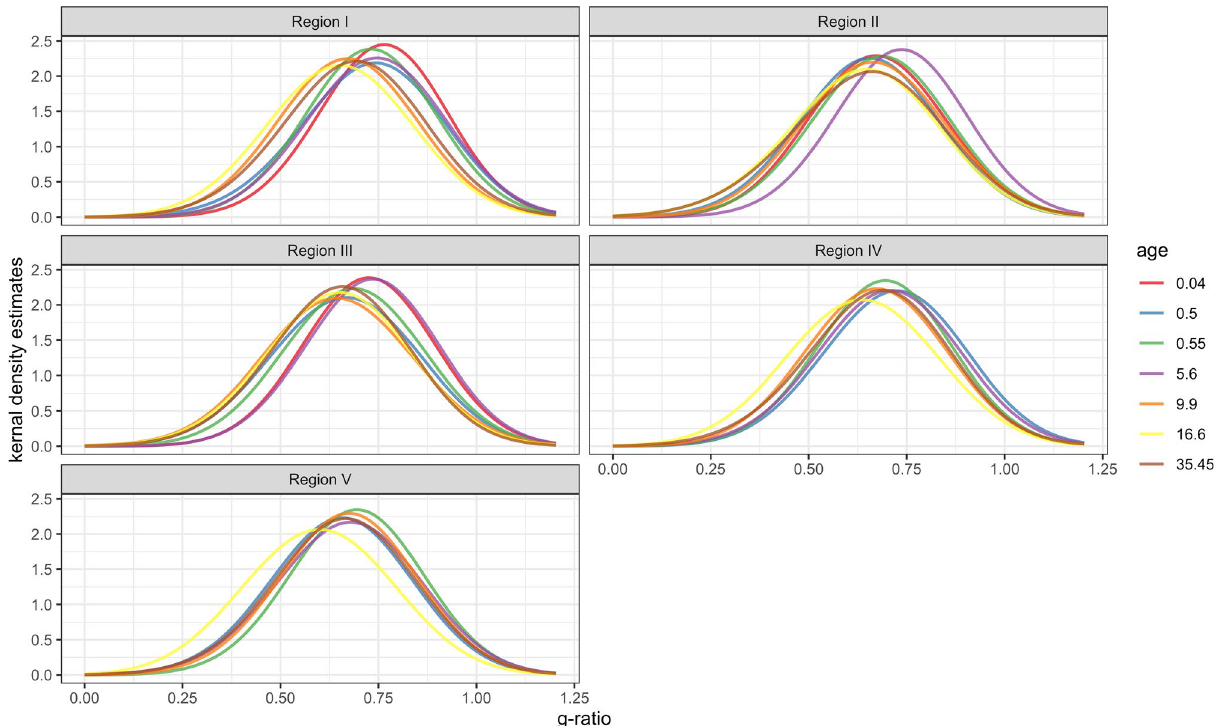
Figure 4. Kernel density estimation plot of g-ratio measurements in callosal Regions I–V. Subjects are referred to by age in years. The youngest subject (0.04 years) was excluded from Regions IV and V, as no myelinated axons were found in these